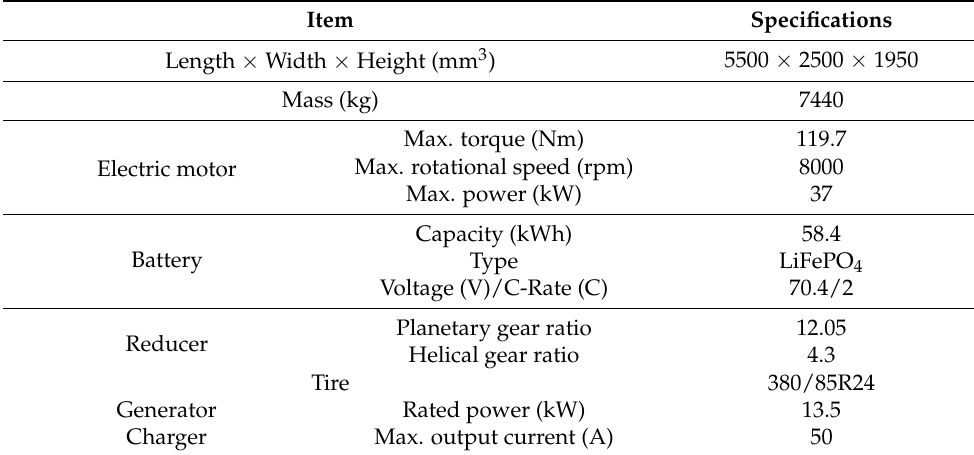
Figure 2. Configuration of the electric AWD tractor (reproduced from [29]). Table 1. Components and specifications of the electric AWD